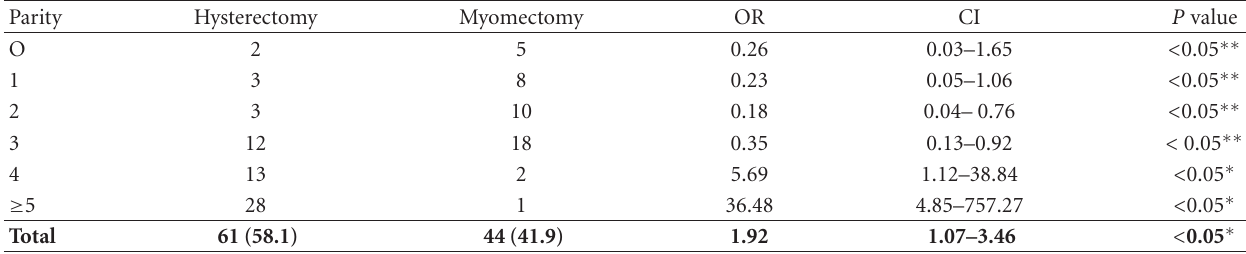
Table 3: Clinical presentation of patients.